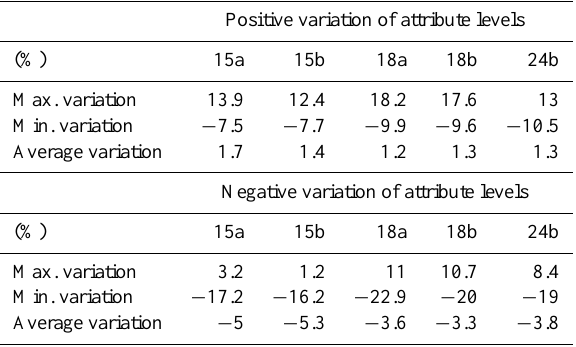
Table 3. Results of sensitivity analysis: influence of changes in at- tribute levels on the preference value for all stakeholder groups in % relative to the total value.